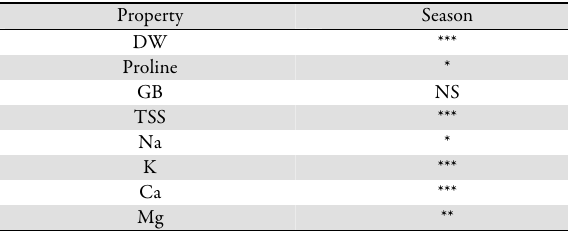
Table 3. Significant effect of seasonal variations on osmolytes and cations in G. struthium present only in plot 3, according to one-way